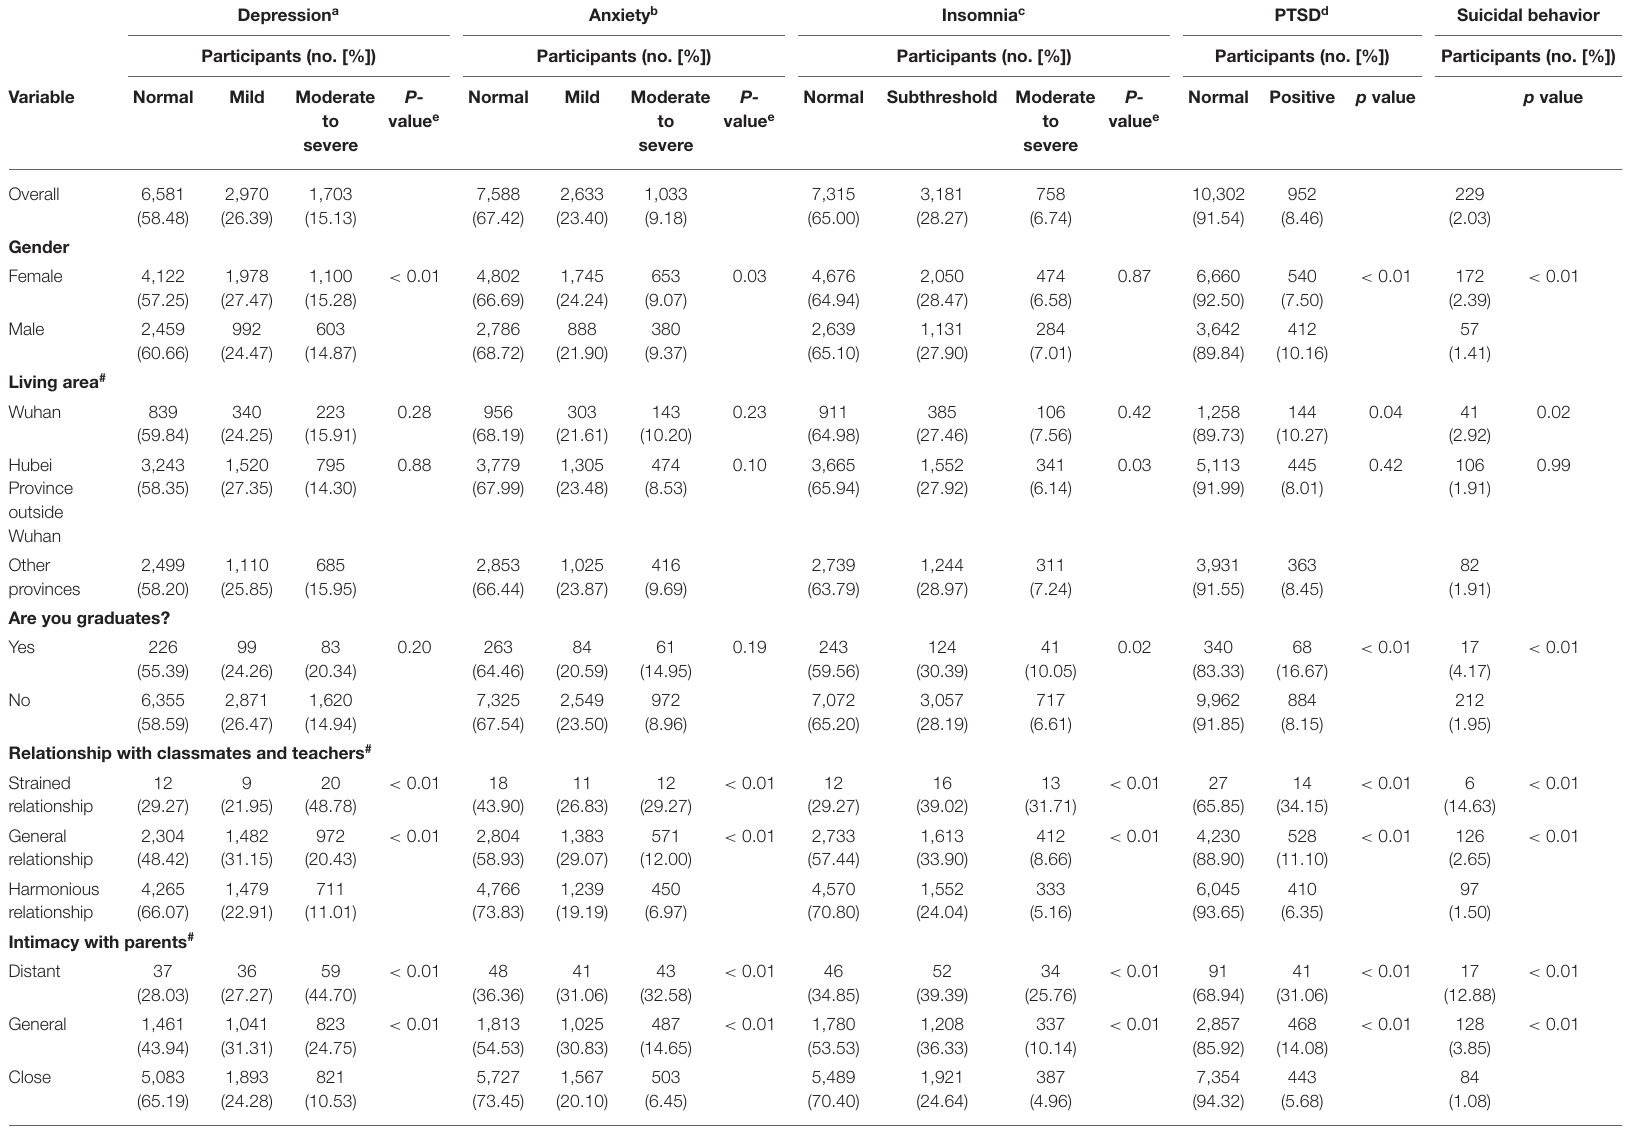
TABLE 2 | Prevalence of symptoms of depression, anxiety, insomnia, and PTSD and suicidal behavior in the students. Depression a Anxiety b Insomnia c PTSD d Suicidal behavior Participants (no. [%]) Participants (no.